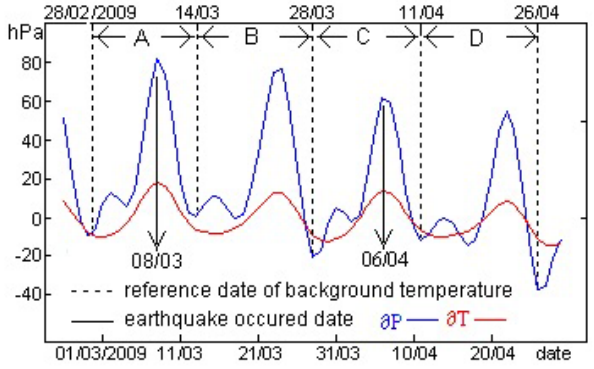
Fig. 2. The periodic changes of ∂ P and ∂ T according to the ATSCTF model for the Abruzzo Earthquake in April